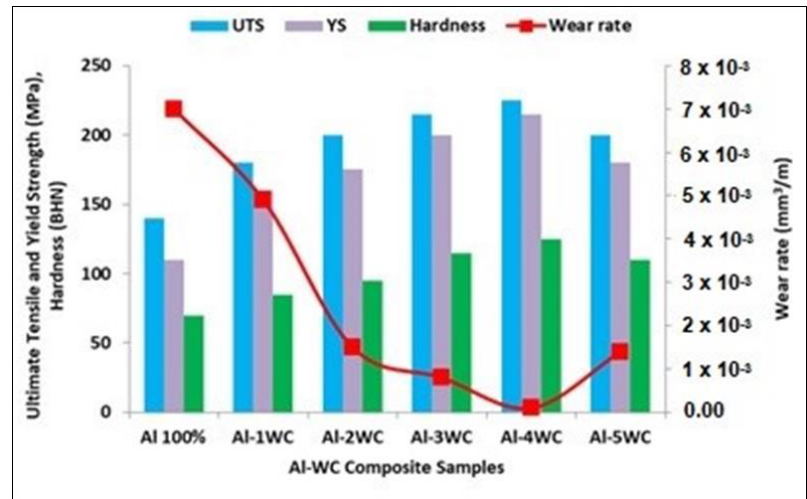
Figure 5. Mechanical and tribological characteristics of Al-WC, adapted from [126].